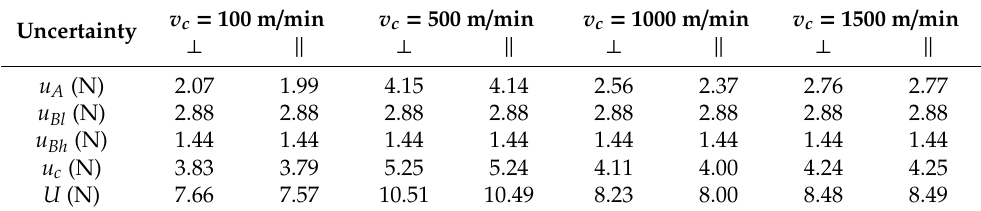
Table 5. Uncertainty and its components for EN AW-2017A T451, perpendicular and parallel milling direction in relation to the rolling direction as well as a p = 0.4 mm.